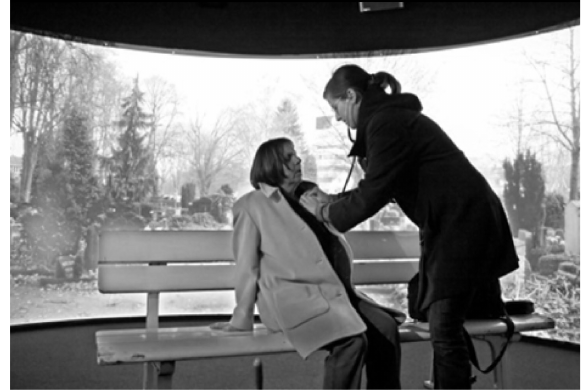
Figure 3. Student takes care of a patent on a